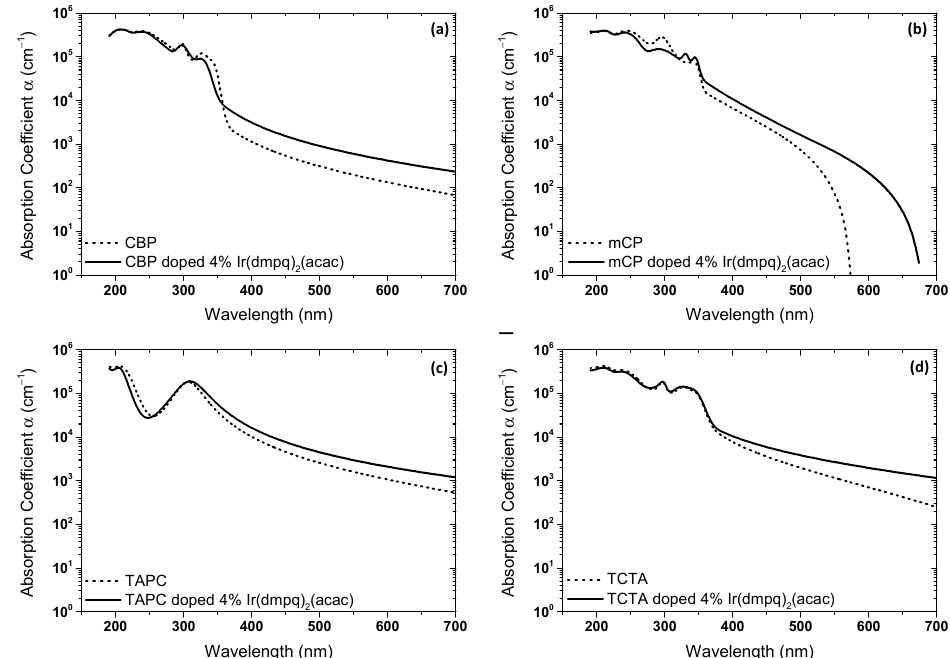
Figure 2. The calculated absorption coefficients, by the SE analysis, versus wavelength of the undoped (dashed lines) and doped (solid lines) organic films: ( a ) CBP; ( b ) mCP; ( c )TAPC; ( d ) TCTA.